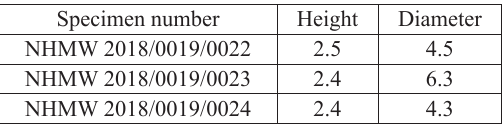
Table 5. Measurements (in mm) of Planorbarius cf. cornu (Brongniart,